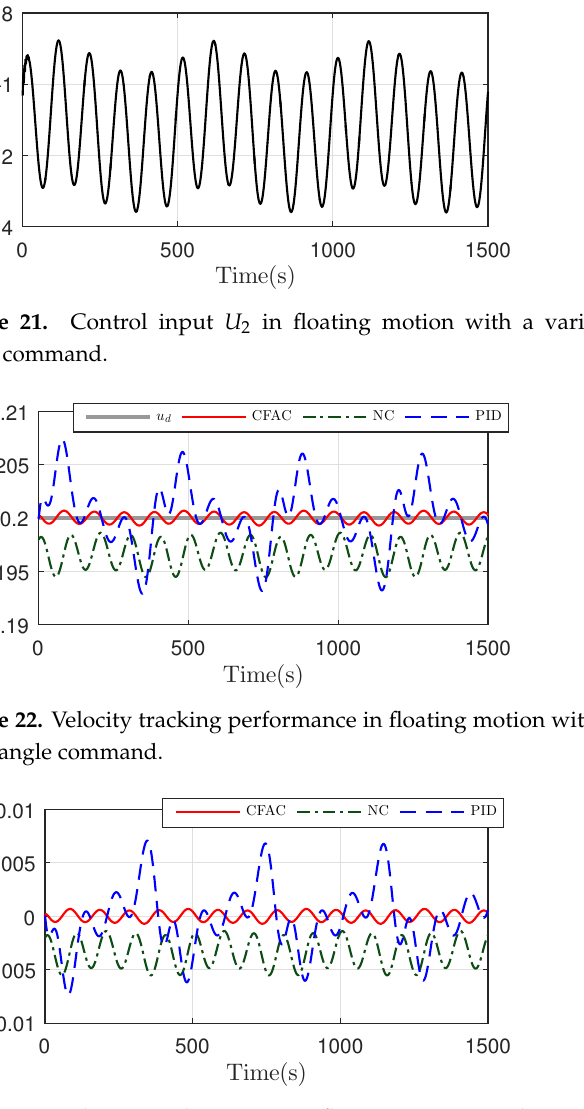
Figure 23. Velocity tracking error in floating motion with a constant velocity and variable pitch angle command.